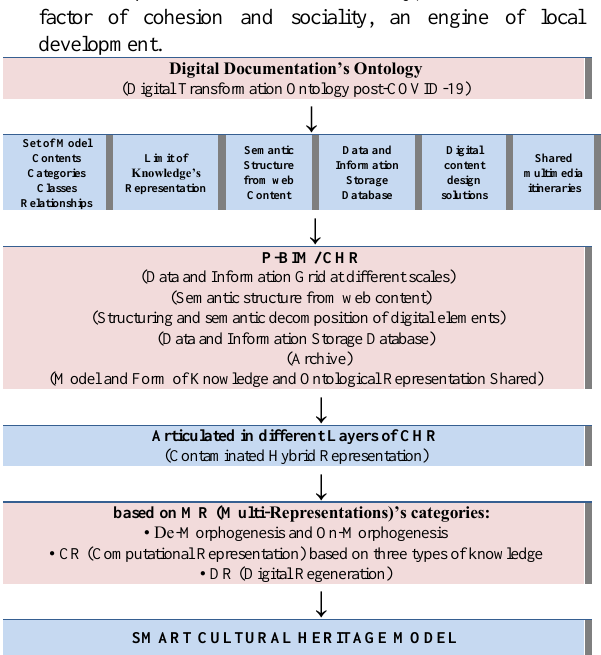
Figure 1 . Digital Documentation’s Ontology